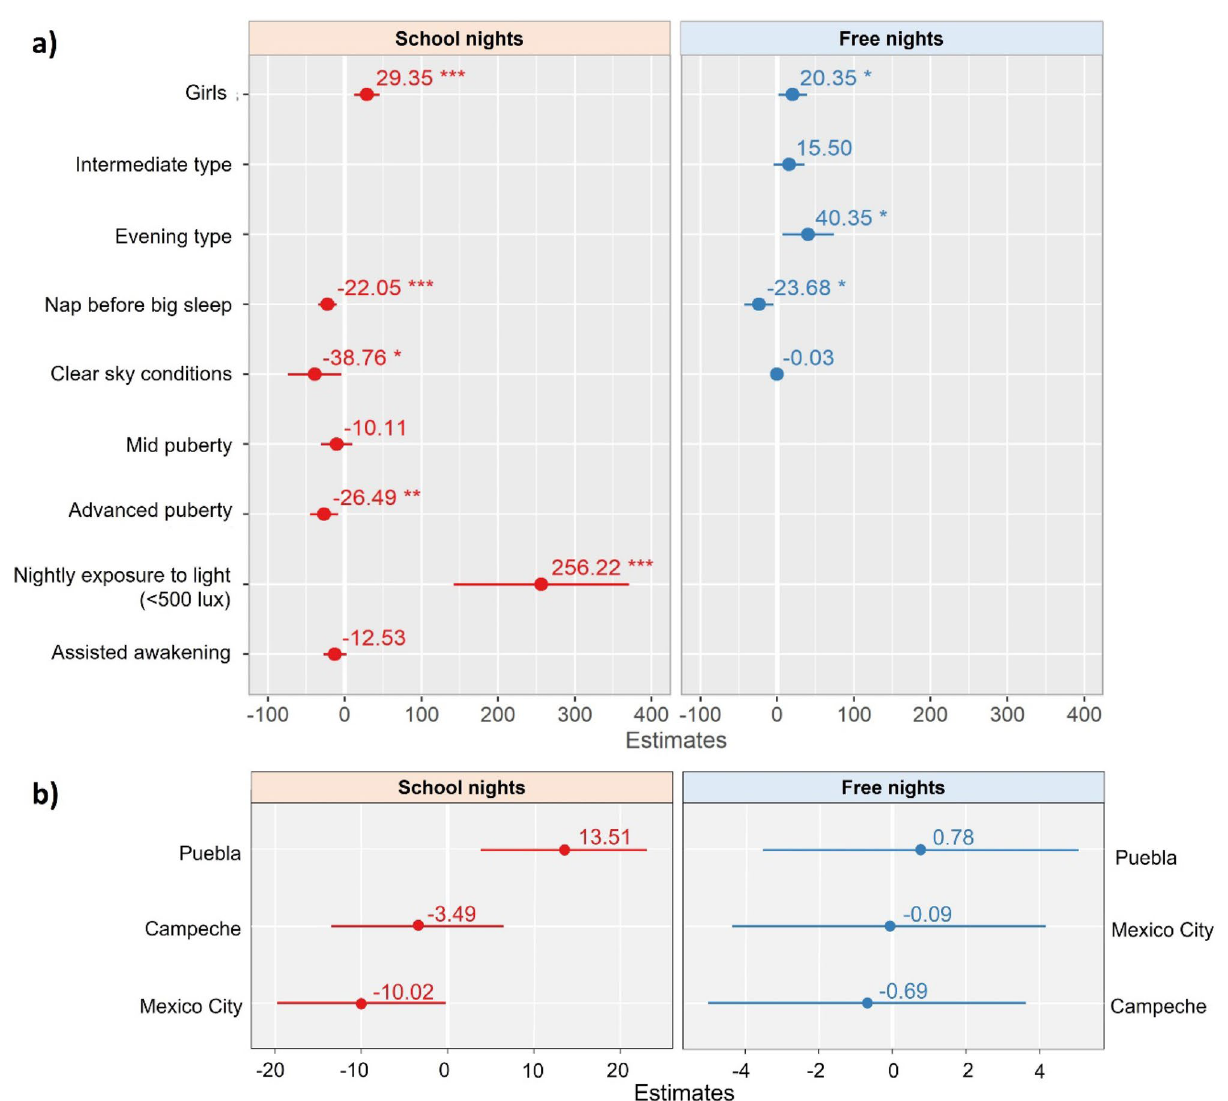
Figure 1. Effect sizes for all-site multilevel models. ( a ) Estimates for fixed effects (i.e., predictor variables with a constant effect on the individuals’ sleep duration). ( b ) Estimates for random effects (i.e., site-level variation on sleep